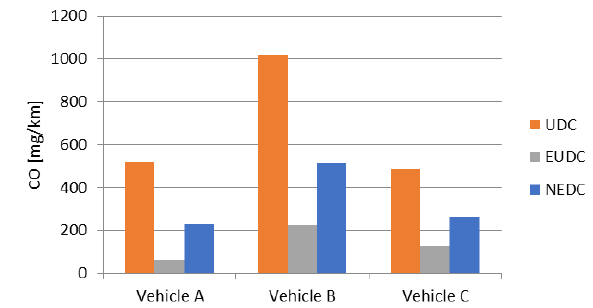
Fig. 3. Carbon monoxide emissions in NEDC test and its particular stages